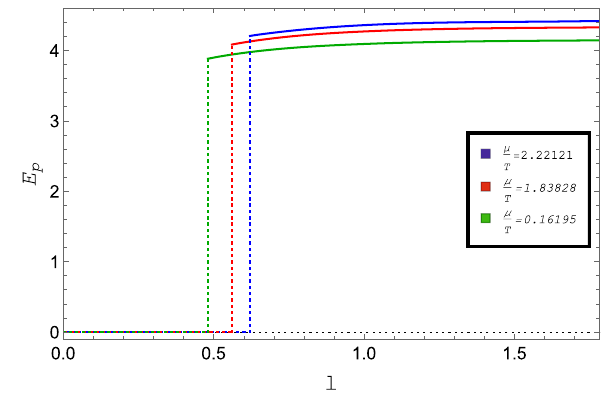
Fig. 7 Left: the EoP with respect to l for three different values of μ and l (cid:3) = 0 . 3 in the field theory with a critical point. Right: the EoP with respect to l for the same values of μ potential corresponding to (22) with d = 3. In both figures, the well-